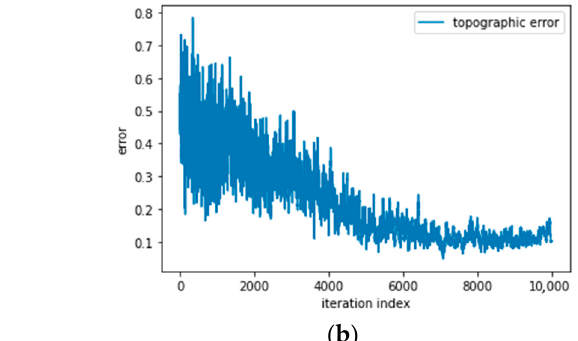
( b ) Figure 9. SOM Colour map: ( a ) U-Matrix Colour Map; ( b ) activation response map. 4.4. Output Map After an initial analysis of the U-Matrix, it is possible to analyse the matrix of occur- rences of BMU responses (Figure 9b) through a colour map. In this case, dark-coloured boxes indicate those nodes that are recalled the most during the training phase and vice versa for the light-coloured boxes. The most responsive nodes have coordinates [5, 10] and [6, 10]. As shown in Figure 10, all readings of the system’s steady state are placed in these two locations. Unlike all other samples in the anomaly tests, the system’s steady- state samples always present the same trend and do not vary its state. Therefore, all steady-state readings are projected at those two nodes.